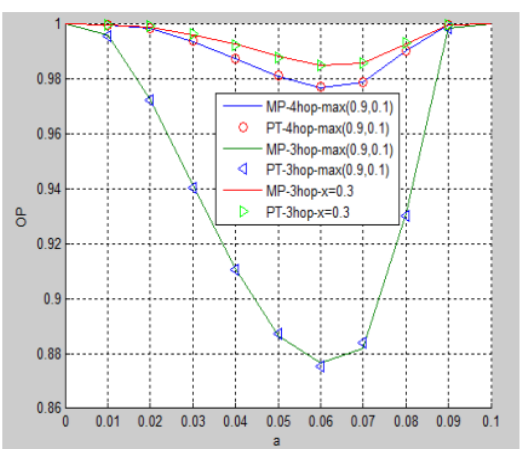
Fig. 9. OP versus I P : K=3, K=4, (x PU , y PU ) =(1,1)